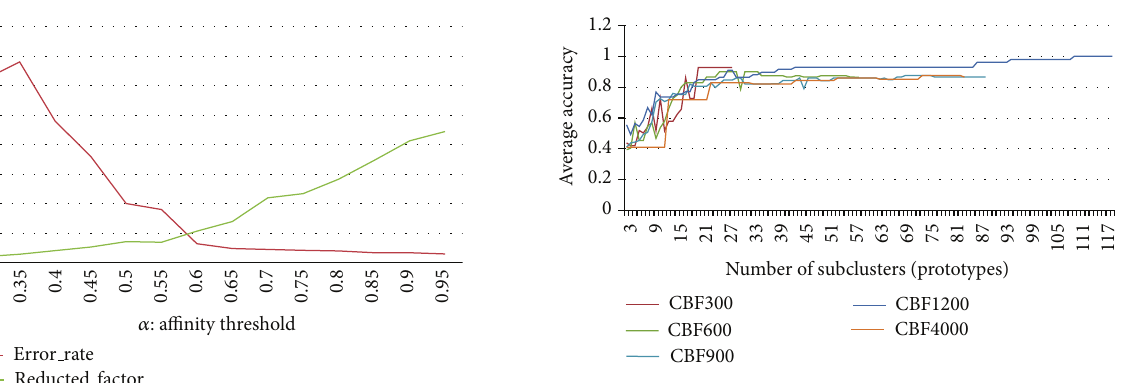
Figure 7: Reduction factor and error rate of the TTC approach across affinity threshold values for the CBF dataset.